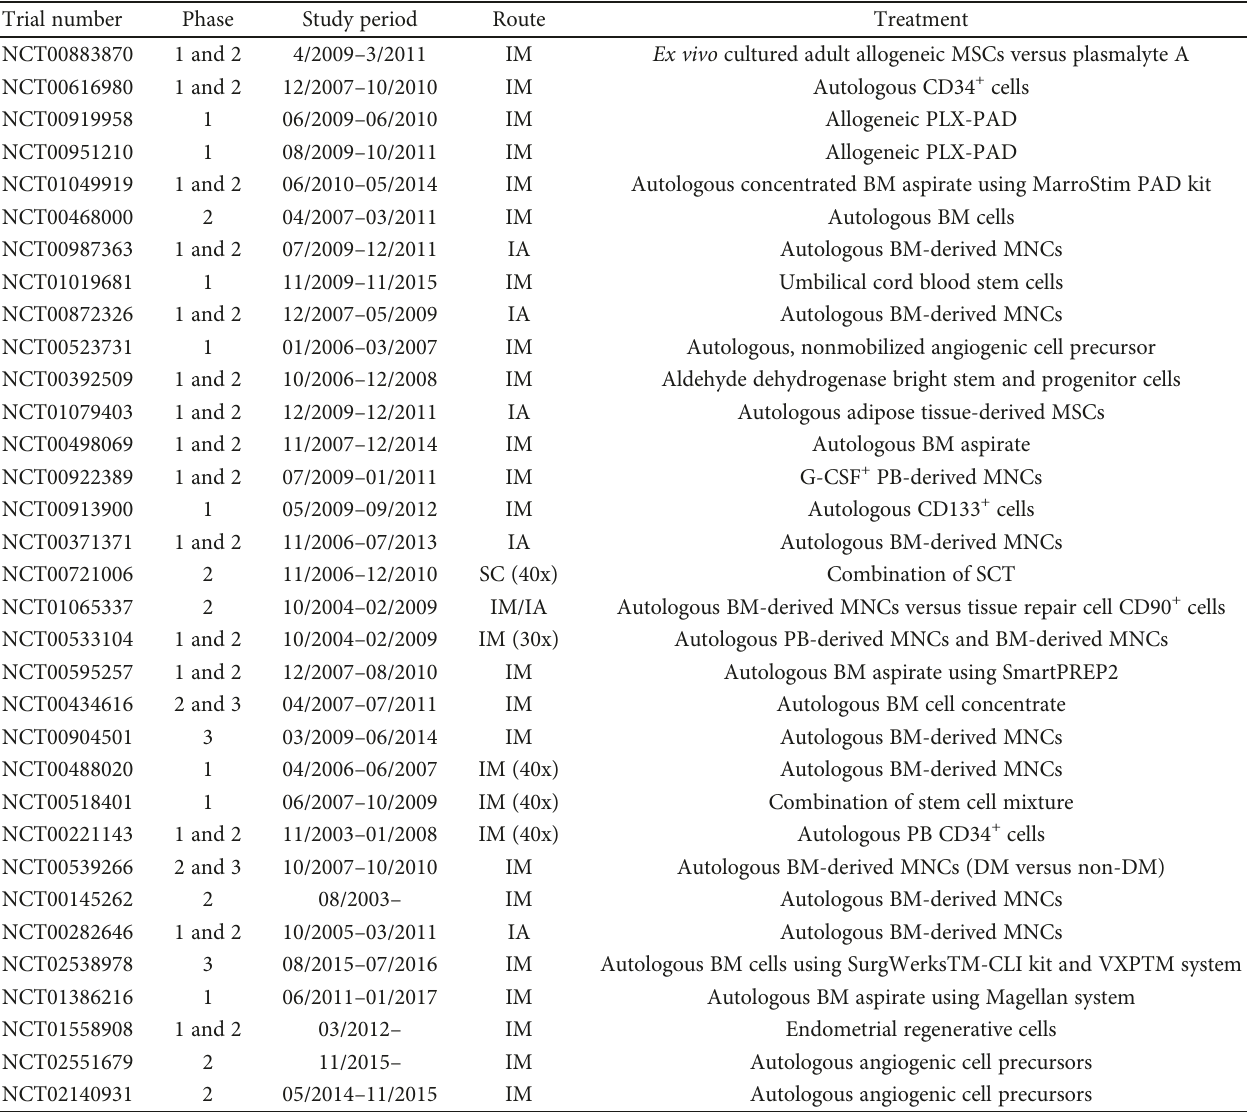
Table 1: Clinical trials using stem cells for treatment of peripheral artery disease related critical limb